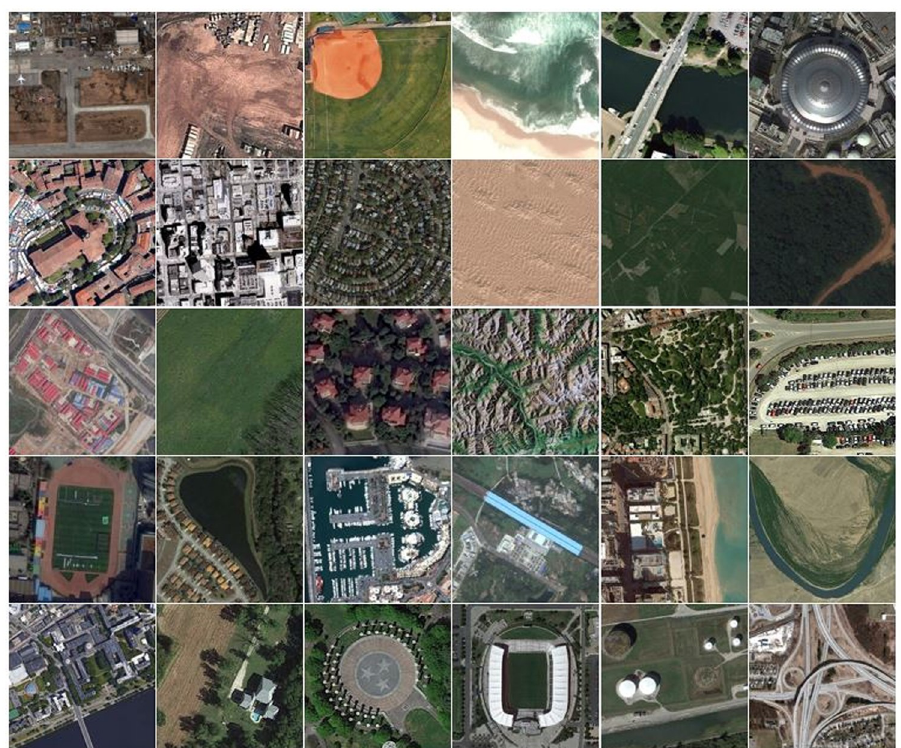
Fig 7. A photo gallery of images from AID image dataset.